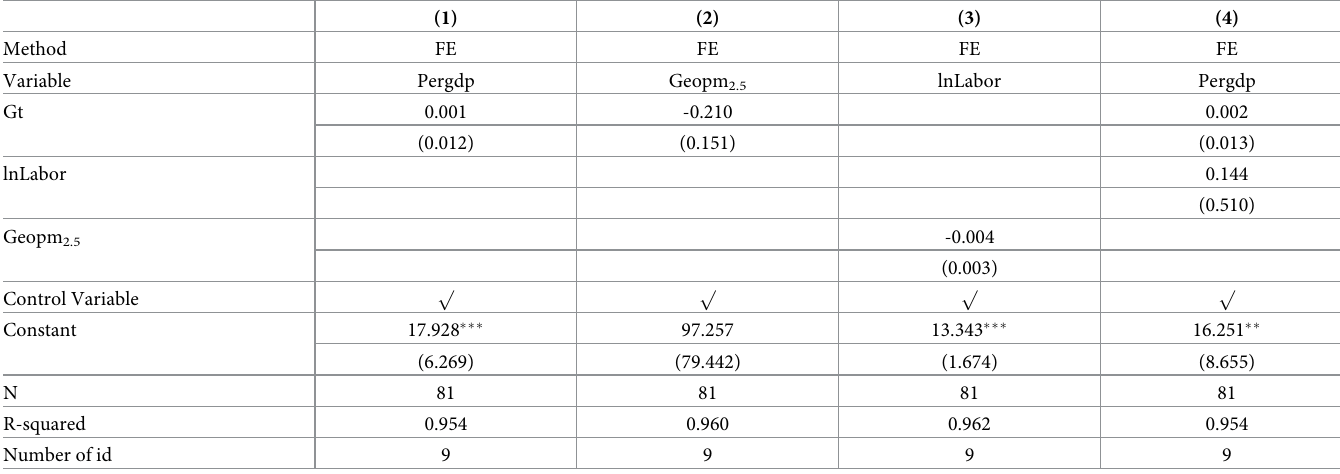
Table 4. Estimation of the mediating effect of labor supply at the central regional